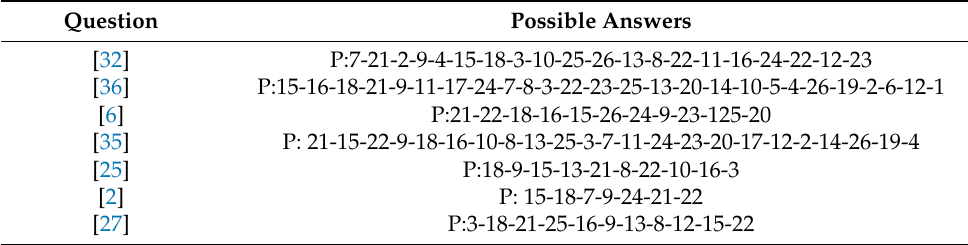
Table A3. List of processes by